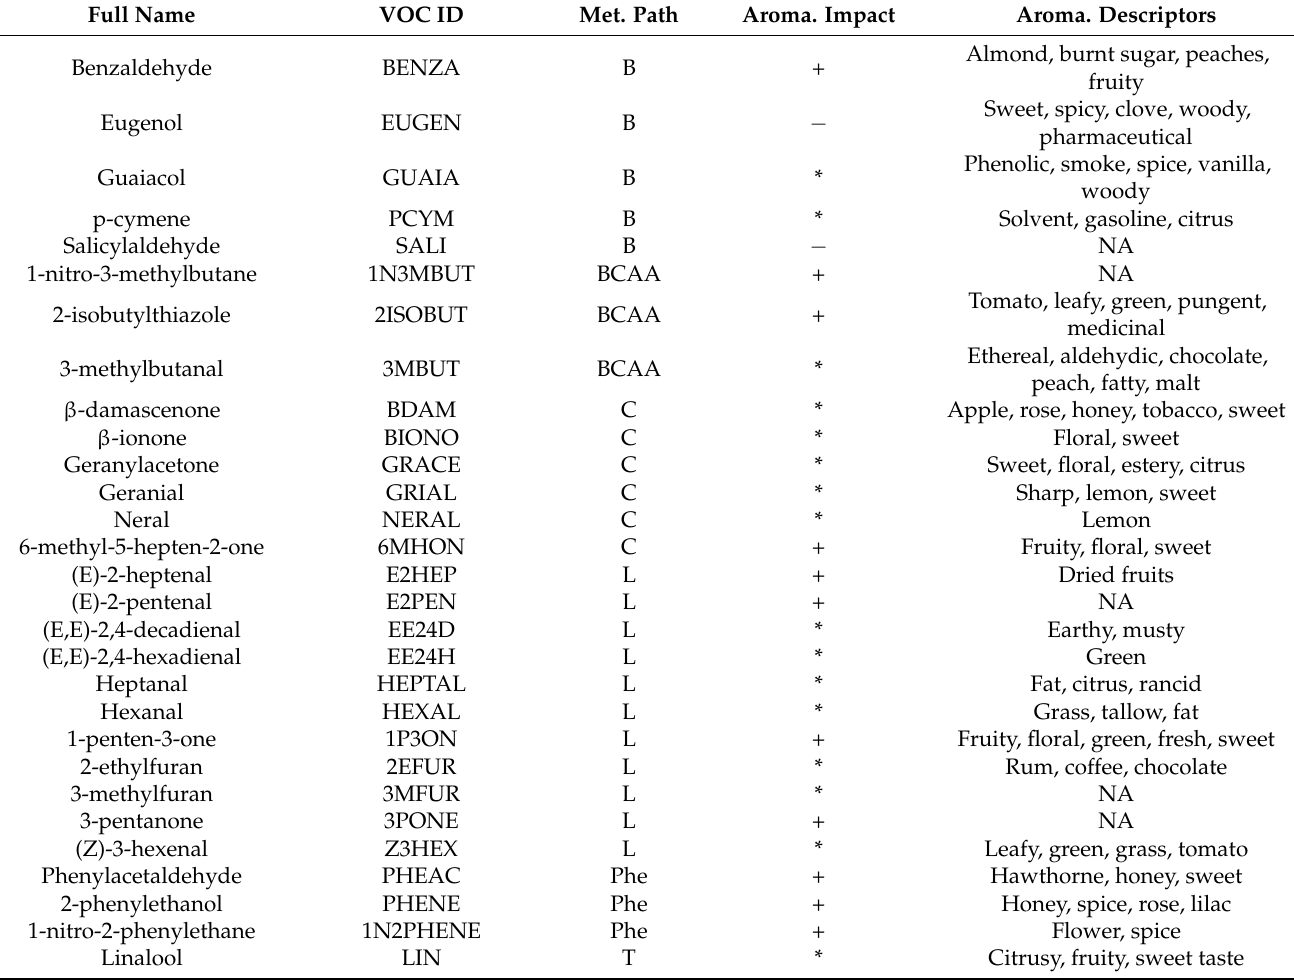
Table 1. Important VOCs for consumer liking among the 46 VOCs, SSC and fruit weight (adapted from [8]). Full